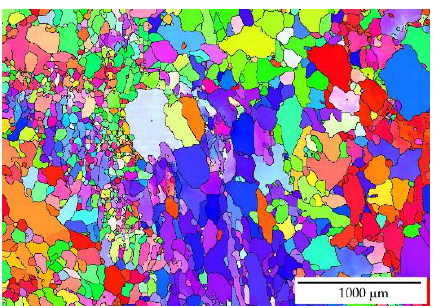
Figure 6. EBSD image of the recrystallized grains in the AlYb AC alloy after ageing at 350 °C for 144 h.